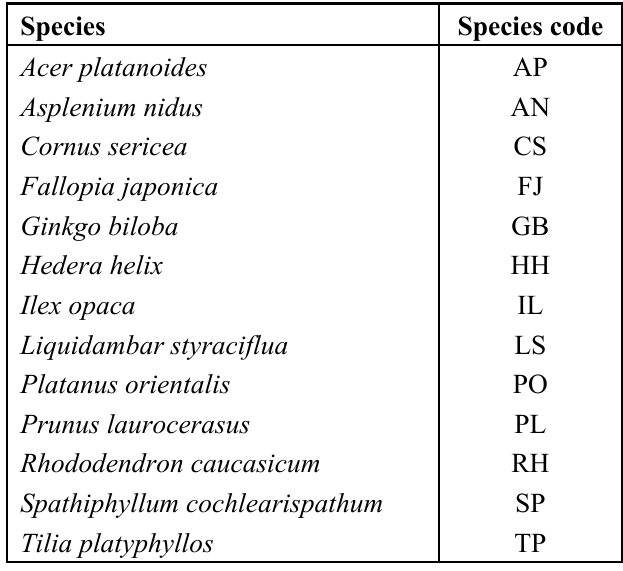
Table 1. The plant species used for spectral measurements. Thirty five (35) leaves were measured per